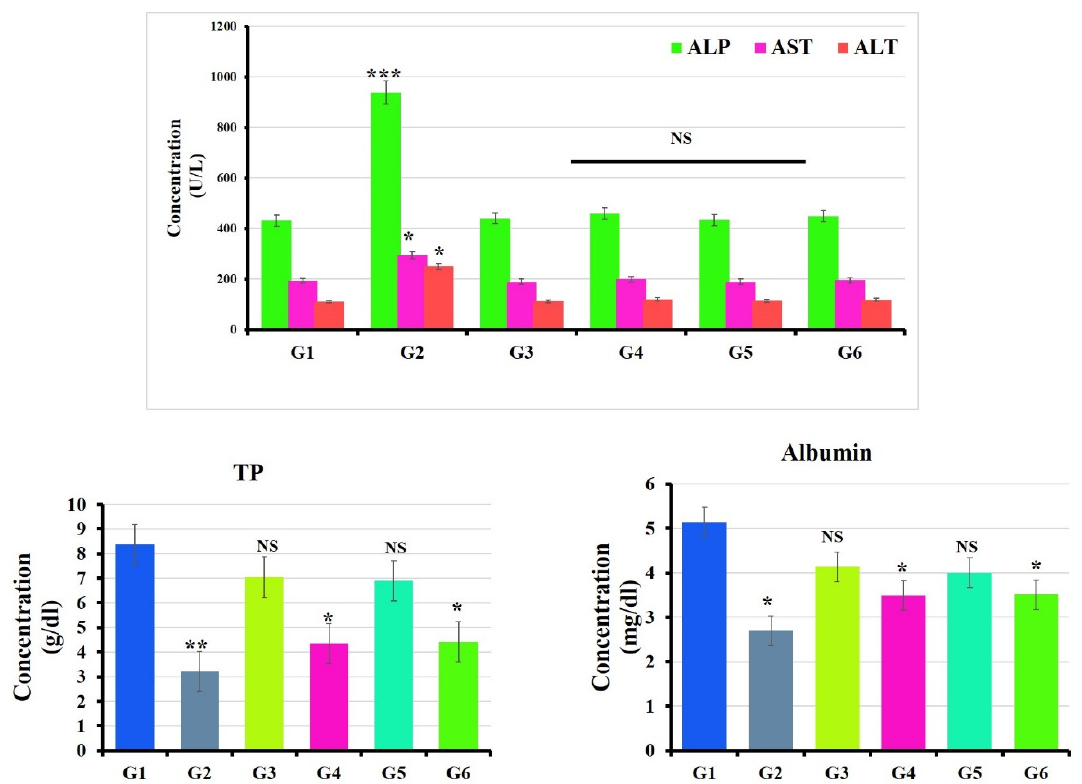
Figure 5. Effect of Moringa and nano ‐ Moringa leaf extracts on liver function in Bisphenol A—Exposed versus normal rats. G1: control. G2: BPA. G3: MOLE. G4: MOLE ‐ BPA. G5: Encap. MOLE. G6: Encap. MOLE ‐ BPA. The data are shown as * p < 0.05 ** p < 0.01 and *** p < 0.001.